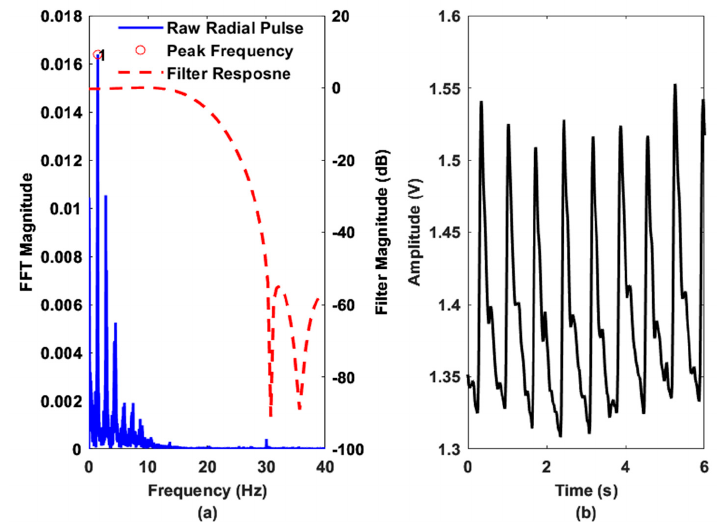
Figure 10. Radial pulse data obtained from the designed compact wearable sensor via Bluetooth telemetry. Here, ( a ) shows the frequency spectrum of the raw radial pulse data along with the applied filter response and ( b ) shows the filtered pulse waveform in time domain.